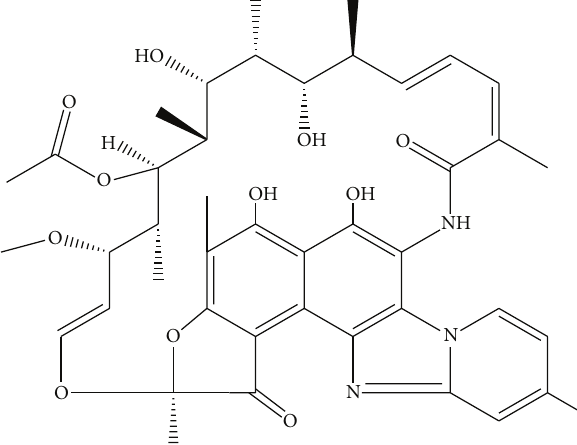
Figure 1: Chemical structure of rifaximin (CAS